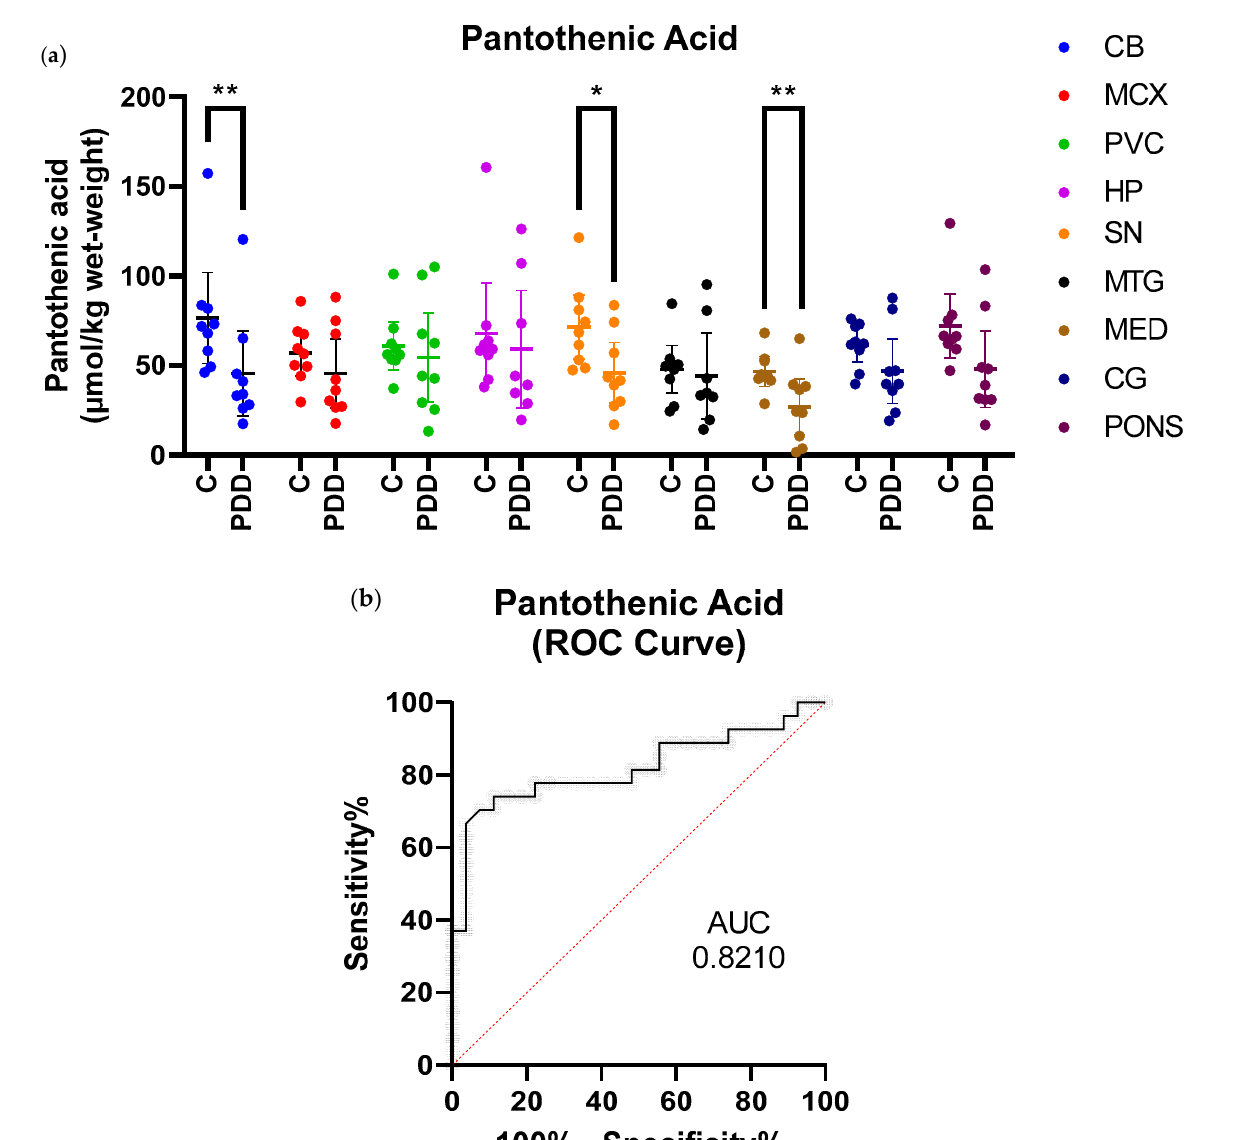
Figure 1. Pantothenic Acid Concentrations in PDD Cases and Controls. ( a ) Mean pantothenic acid concentrations ± 95% confidence intervals in µmol/kg wet-weight. Case–control differences were determined using Mann–Whitney U test. * p < 0.05; ** p < 0.01. C = Controls; PDD = PDD cases. ( b ) receiver-operating characteristic (ROC) curve for pantothenic acid in all brain regions showing significant case–control differences (SN, CB, and MED). Area under curve (AUC) value was 0.8210 with p < 0.0001.